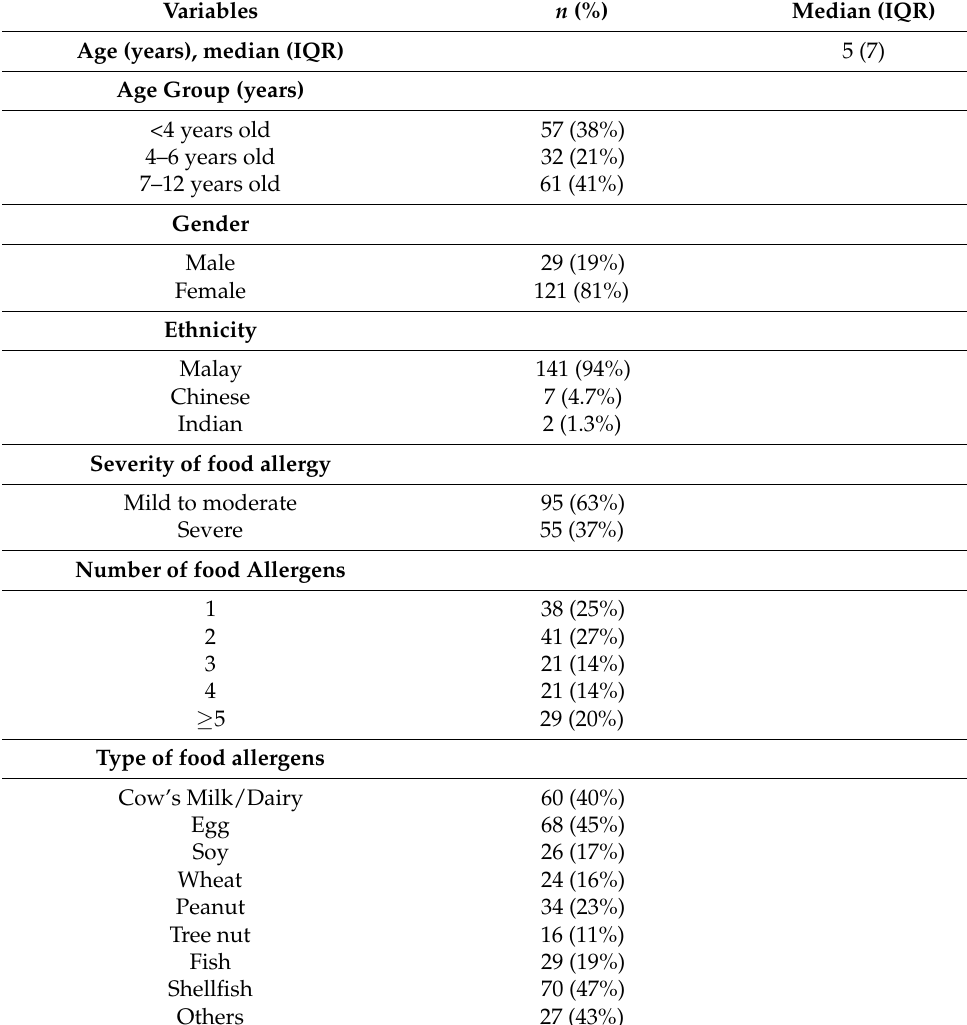
Table 1. Demographic and clinical characteristics of children with food allergies ( n =